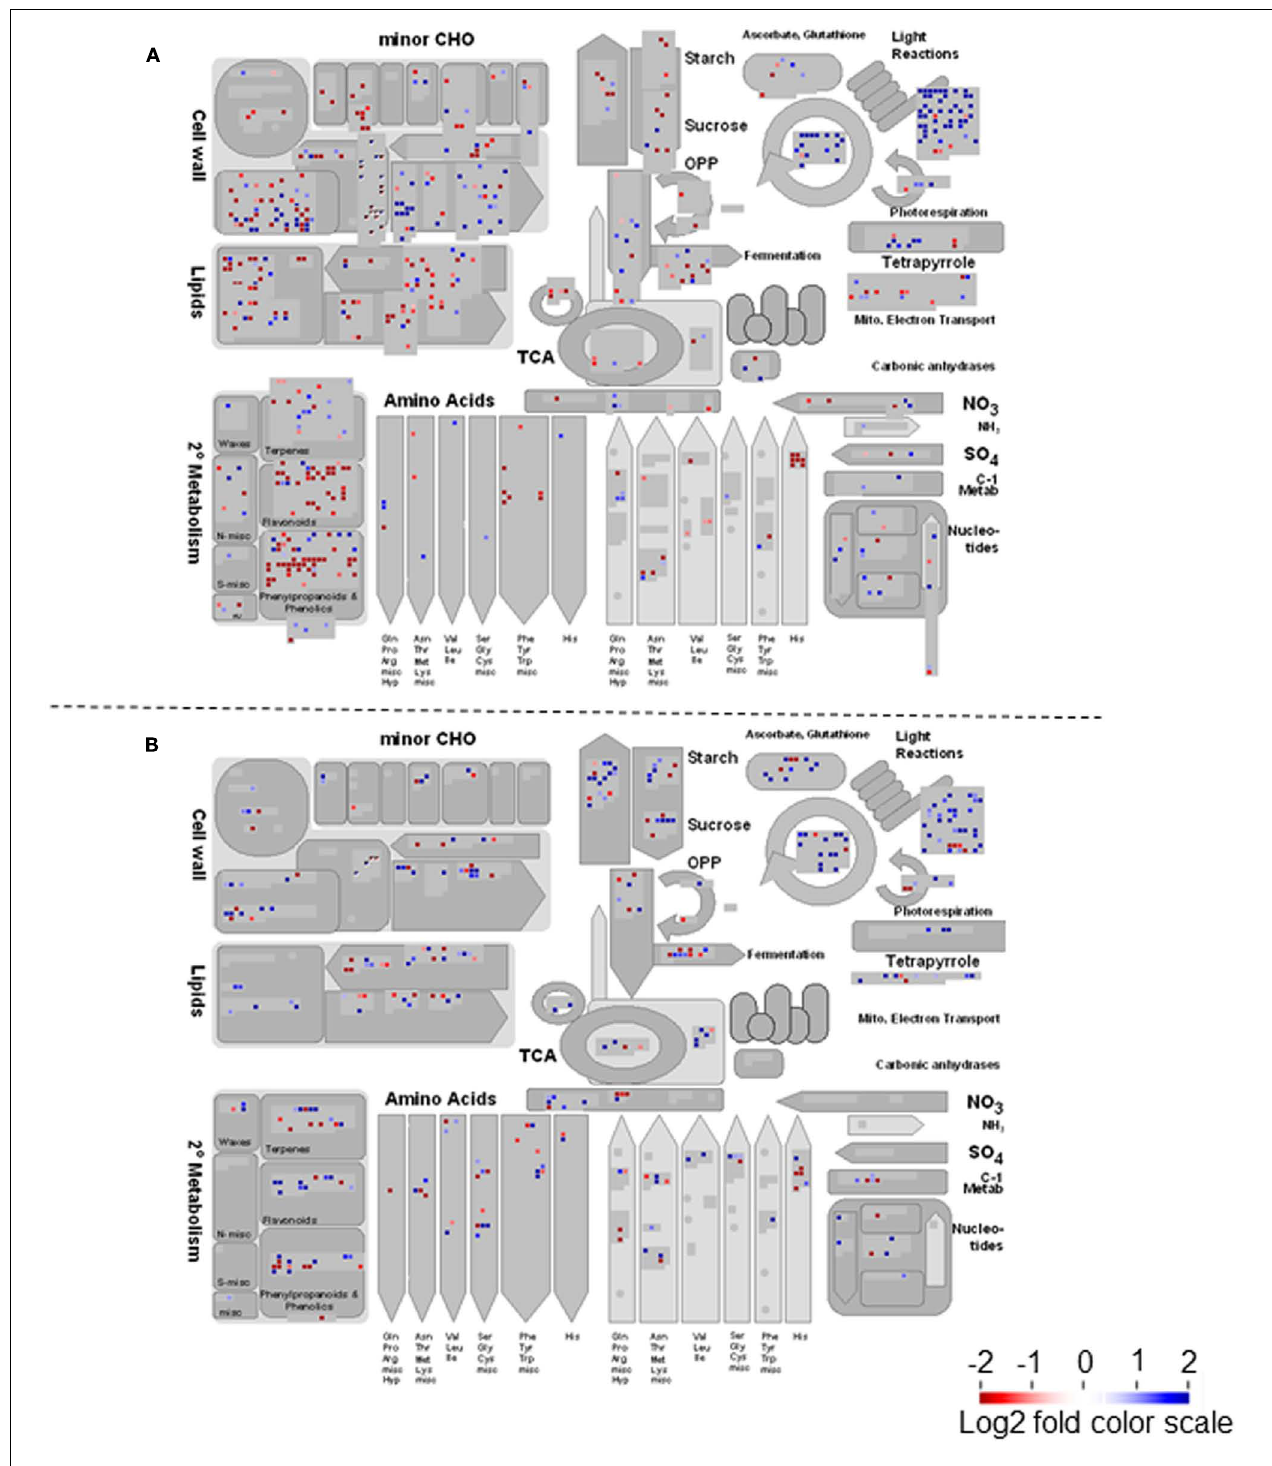
classed according to the MAPMAN classifications (Thimm et al., 2004; Usadel et al., 2005) adapted for lotus (Sanchez et al., 2008) and tomato (Urbanczyk-Wochniak et al., 2006), respectively. Red indicates a decrease whereas blue indicates an increase [see color scale in (B)